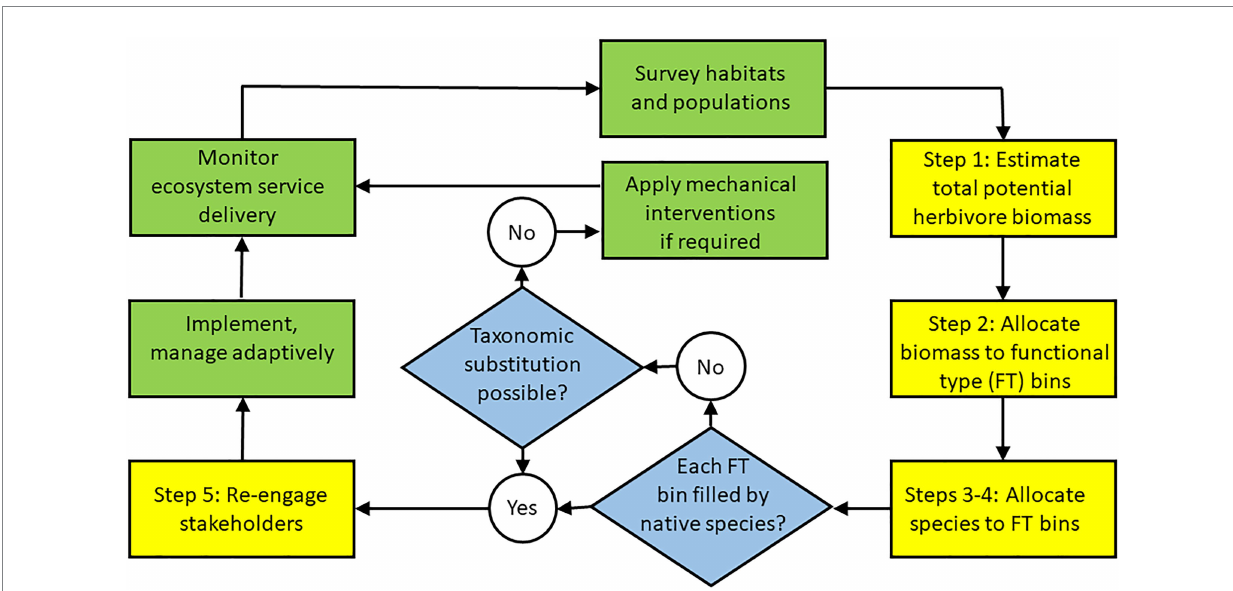
FIGURE 1 The process proposed to operationalize a rewilding project. Green boxes are actions performed by practitioners on the land. Yellow boxes are analyses performed in collaboration among practitioners, technical resources, and stakeholder groups, following steps described in the text. Blue diamonds are decisions on community assembly ultimately requiring ratification by stakeholders.